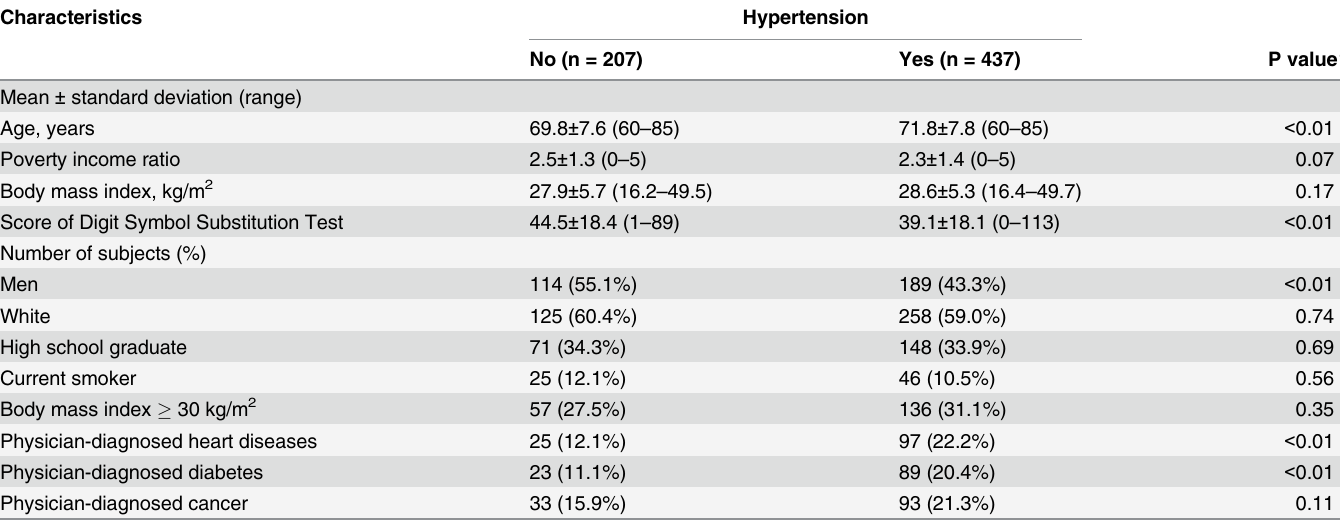
Table 1. Characteristics of study subjects.